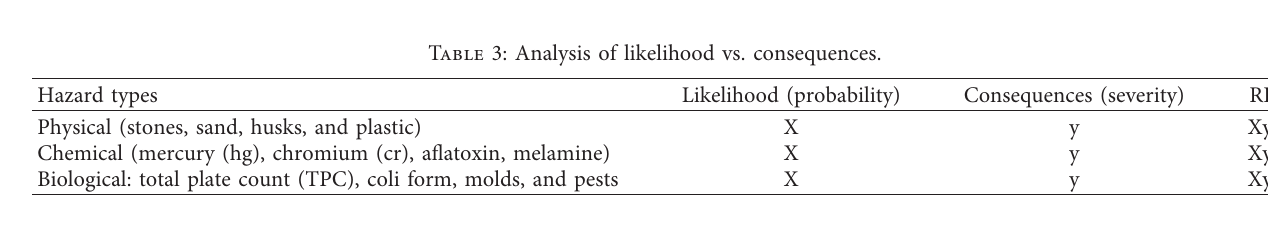
Table 4: Risk index and its management